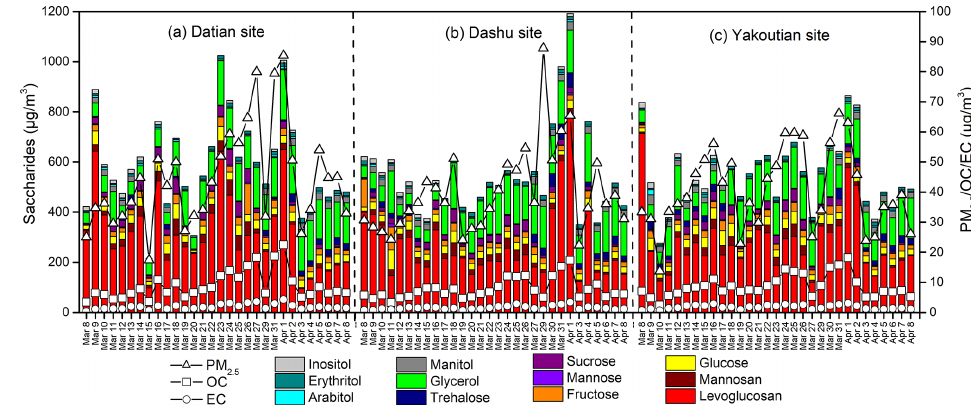
Figure 1. Temporal variations of OC, EC, PM 2 . 5 and total sugars at the three sites during the sampling periods.